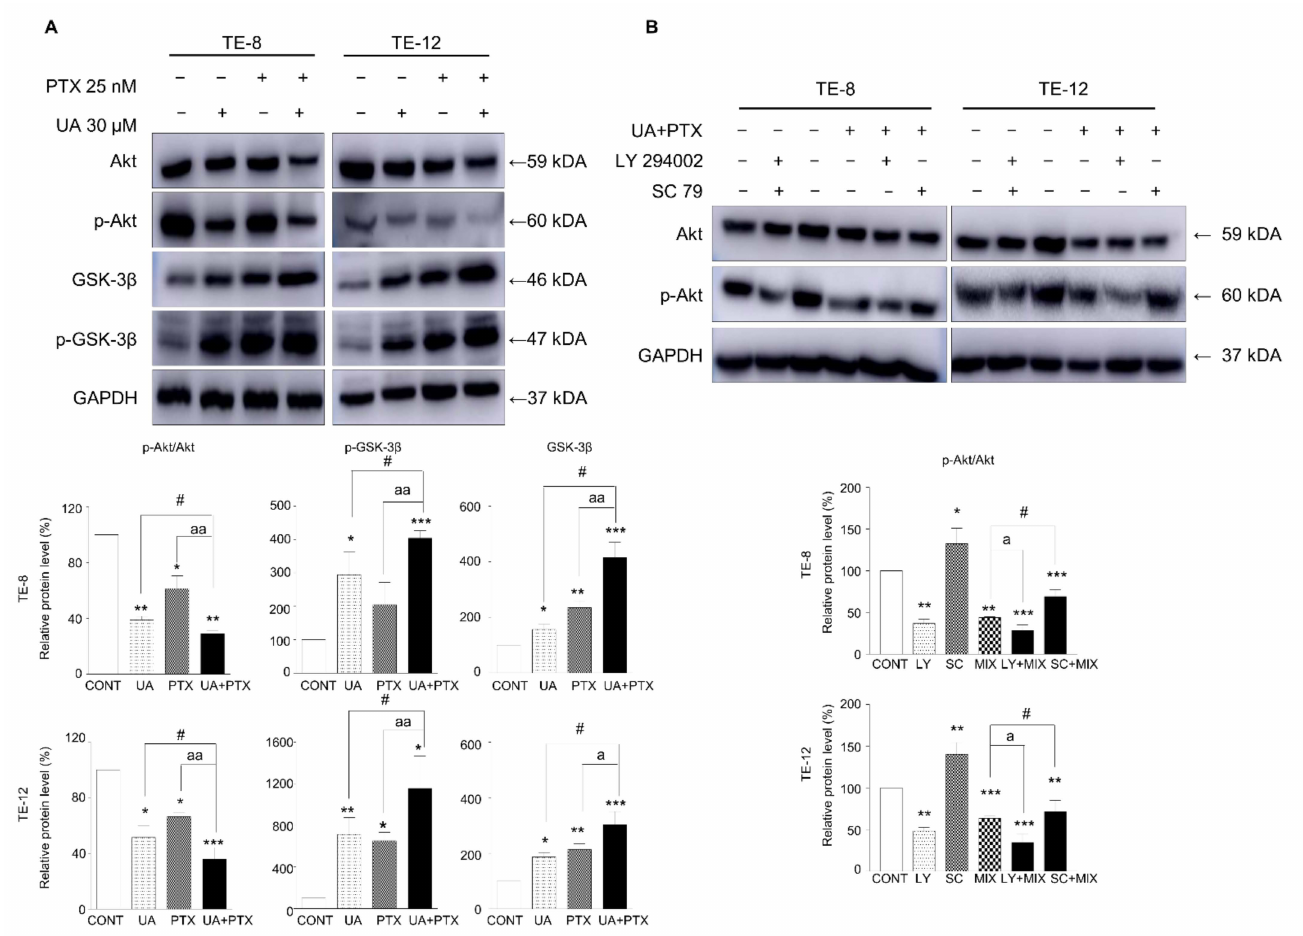
Figure 5. UA and PTX downregulated Akt signaling in ESCC cells. ( A ). The expression of Akt, p-Akt, GSK-3 β , and p-GSK-3 β was examined by western blotting in the presence of UA 30 µ M, PTX 25 nM, or both. ( B ). In the presence of an Akt inhibitor (LY294002) or Akt agonist (SC79), Akt and p-Akt were measured by western blotting with or without the UA and PTX combination treatment. The cells were pretreated with LY294002 (10 µ M) or SC79 (10 µ M) for 2 h and then treated with UA 30 µ M and PTX 25 nM for 48 h. GAPDH is the internal control. Data are expressed as the mean ± SE. Quantification of bands was calculated using Image J. *, compared with the control group; # , UA compared with the UA plus PTX combination group; a , PTX group compared with the UA plus PTX combination group. # , a , * p < 0.05; aa , ** p < 0.01 and *** p < 0.001. CONT, control; LY, LY294002; SC, SC79; MIX, combination treatment of ursolic acid 30 µ M and paclitaxel 25 nM; UA, ursolic acid 30 µ M; PTX, paclitaxel 25